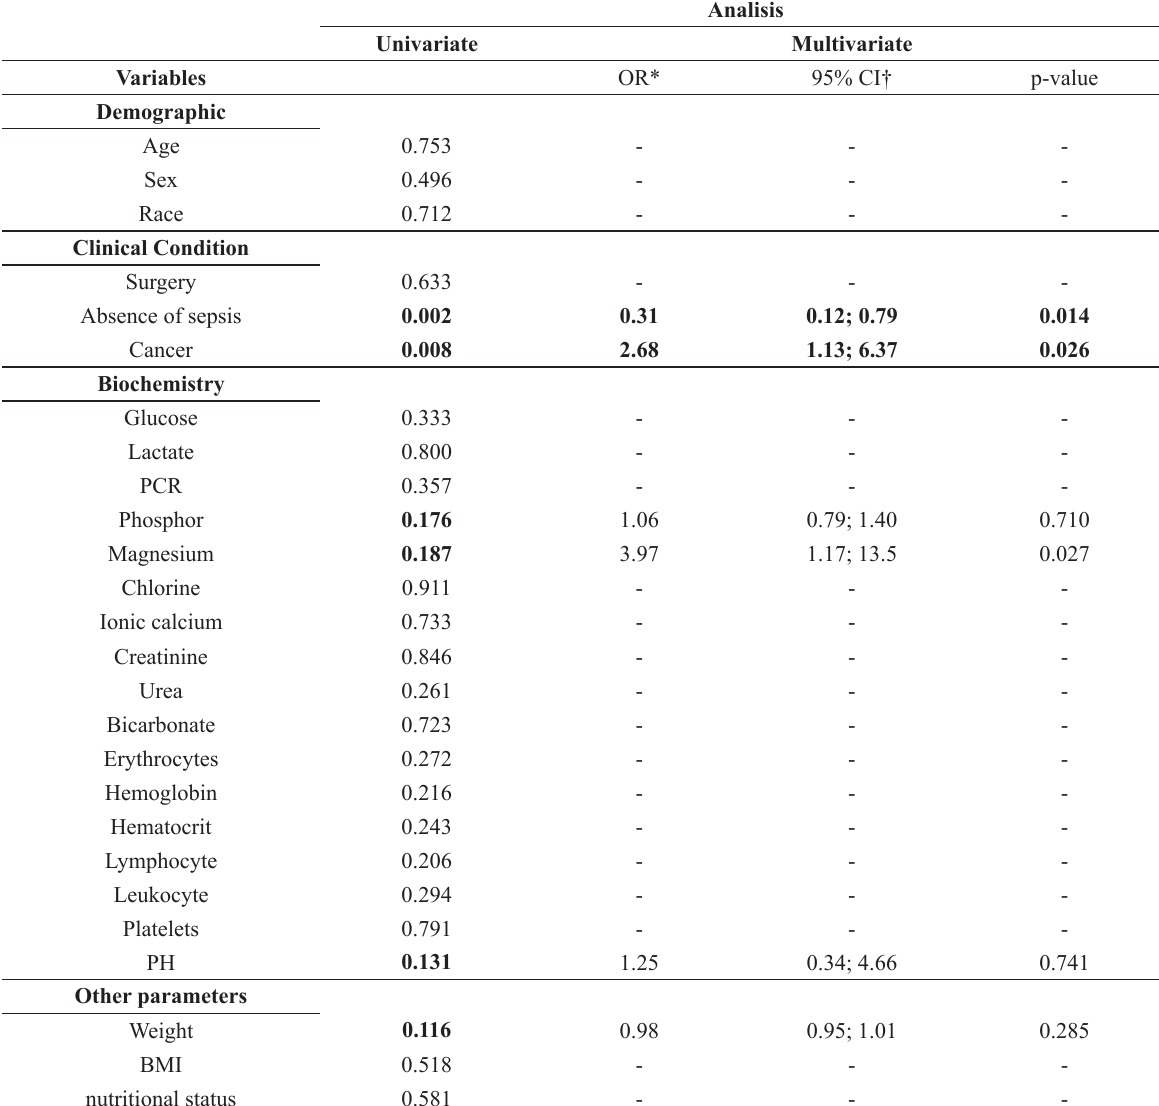
Univariate and multivariate analysis for